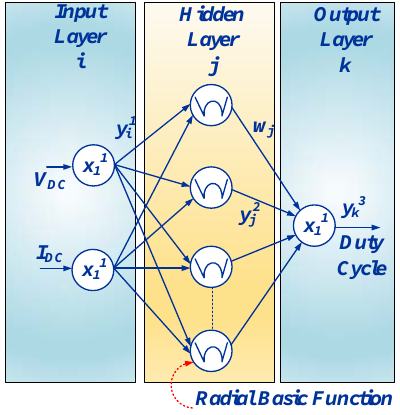
Figure 4. Radial basis function network (RBFN) based MPPT technique.